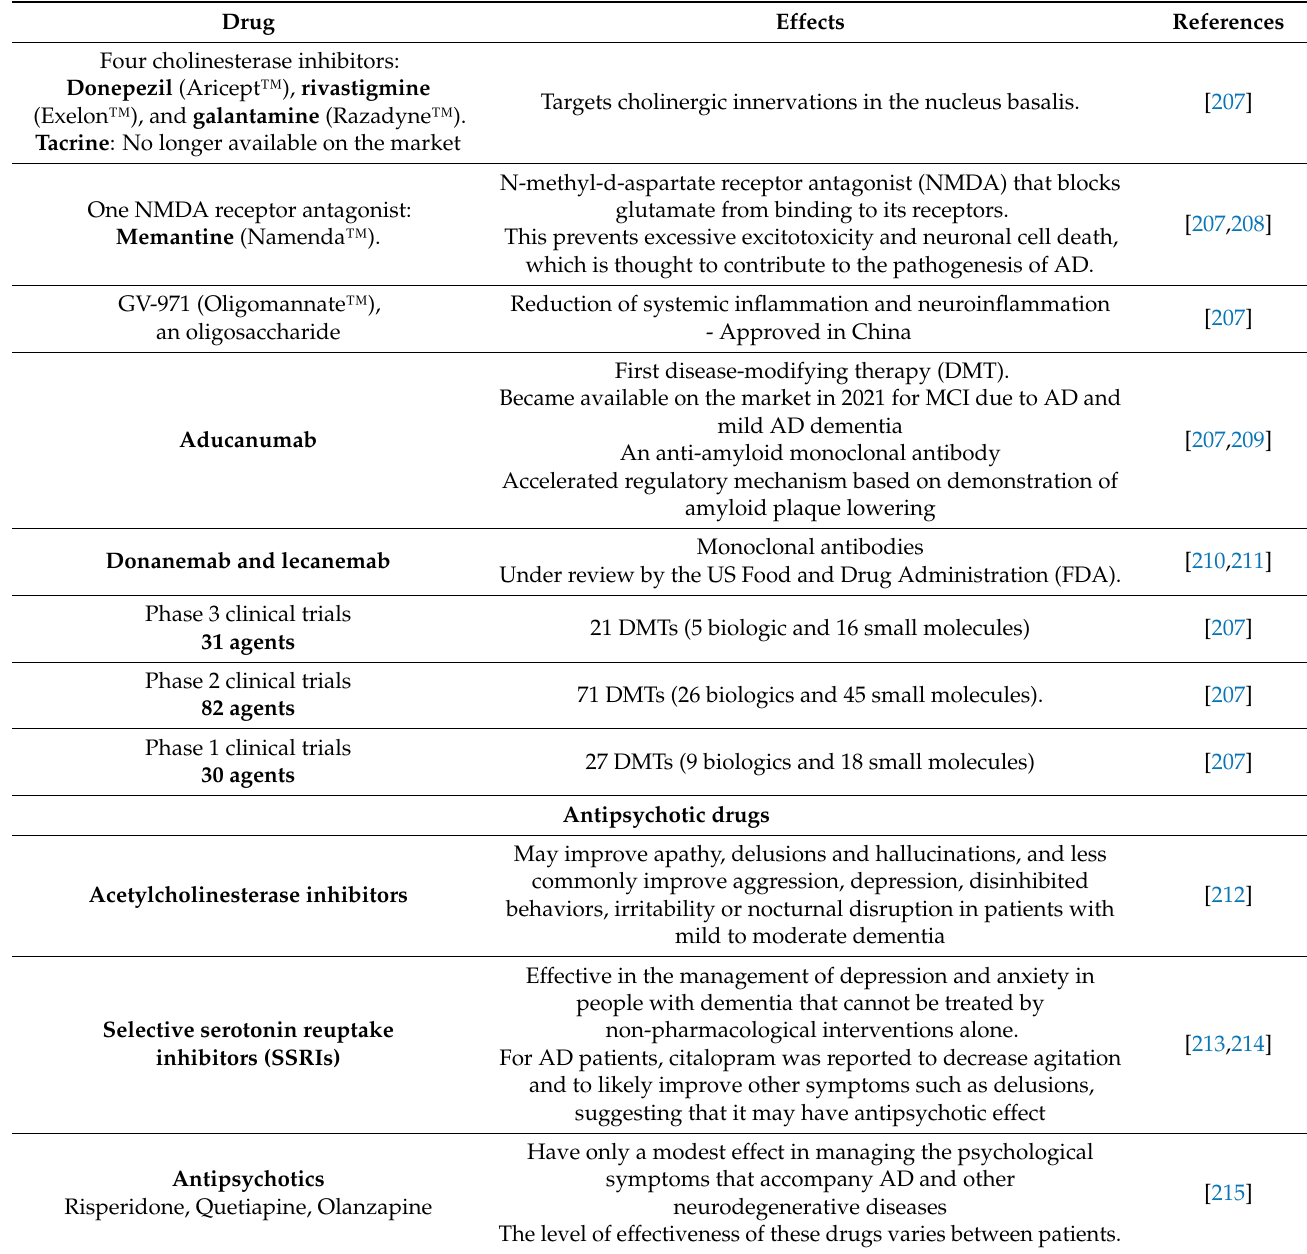
Table 3. Current status of AD drugs, approved and under